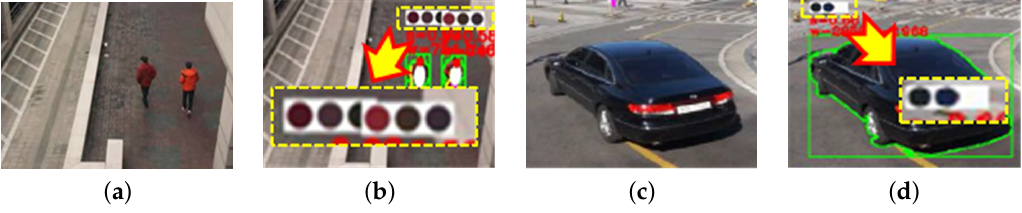
Figure 10. Selection of the representative colors from the candidate colors computed by the K-means clustering algorithm: ( a ) input image with two people; ( b ) the result of color selection; ( c ) an input image with a vehicle; ( d ) the result of color